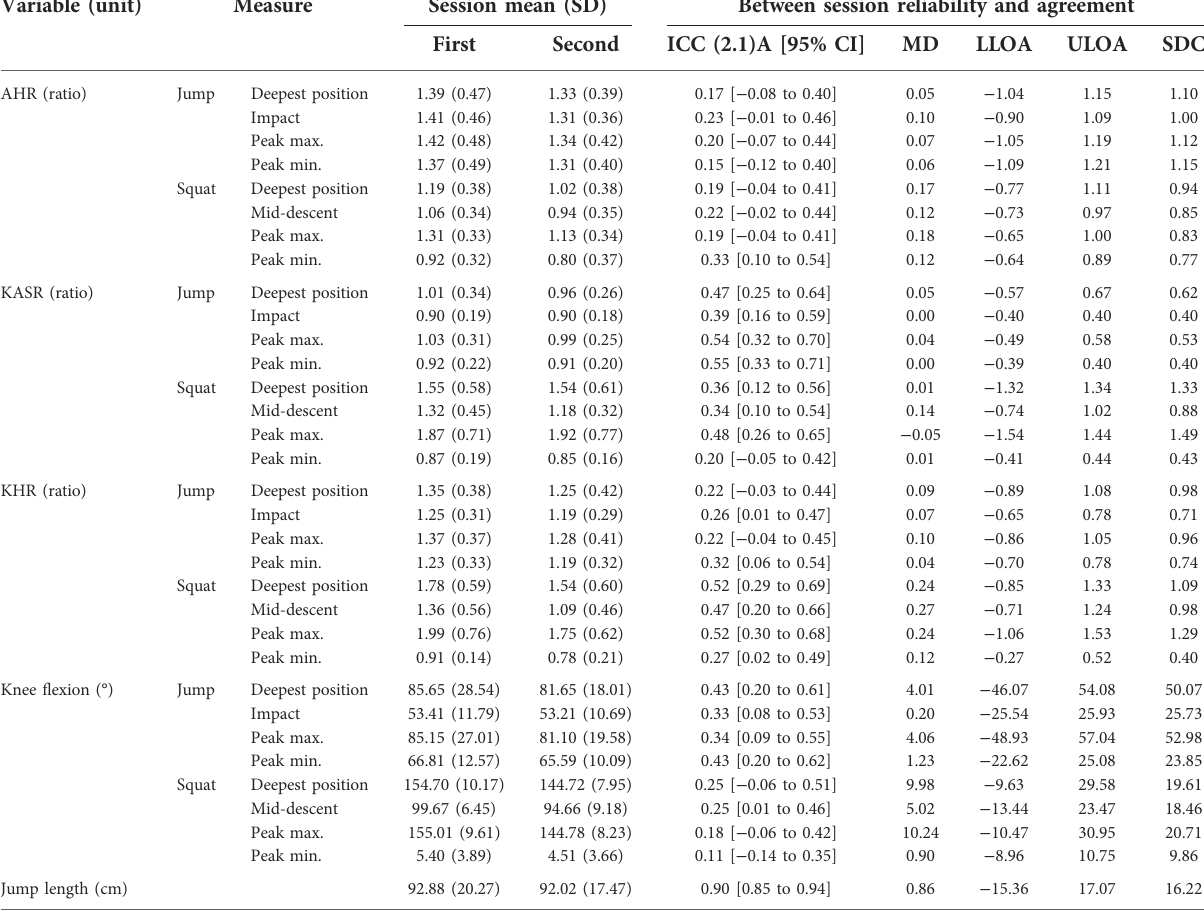
TABLE 1 Week-to-week test-retest reliability and agreement of 4 kinematic variables and jump length measured in 63 preschool children using markerless motion capture equipment. Variable